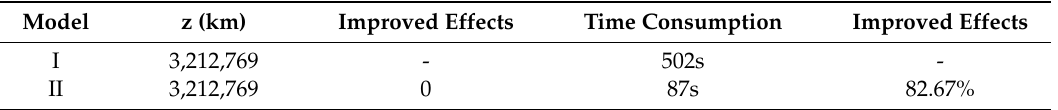
Table 6. Numerical comparison results.